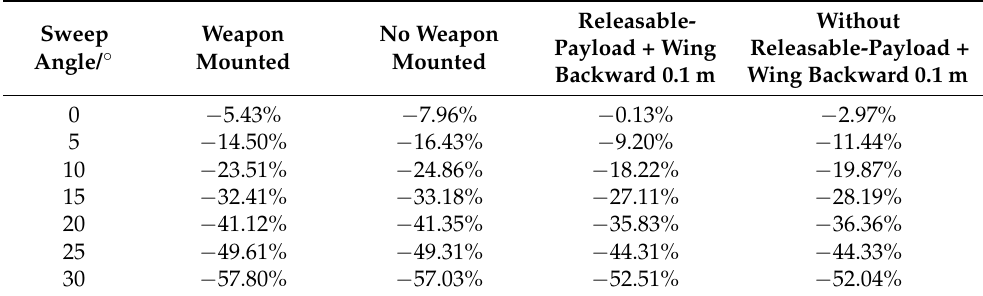
Table 5. The value of longitudinal static stability margin at different sweep angles of a single-section wing